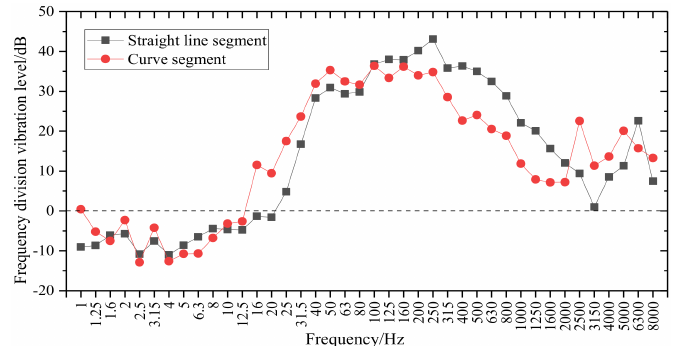
Figure 19. Comparison of frequency-division vibration-level insertion